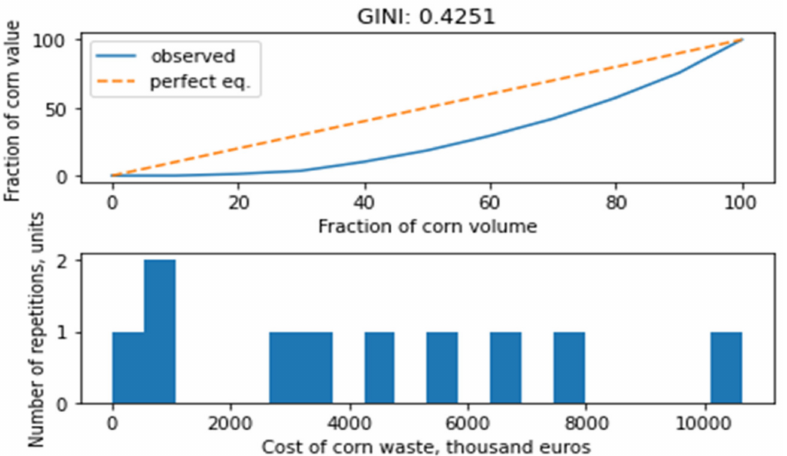
Figure 7. Lorentz curve, built on indicator III, for the conditions of Khmelnytskyi region